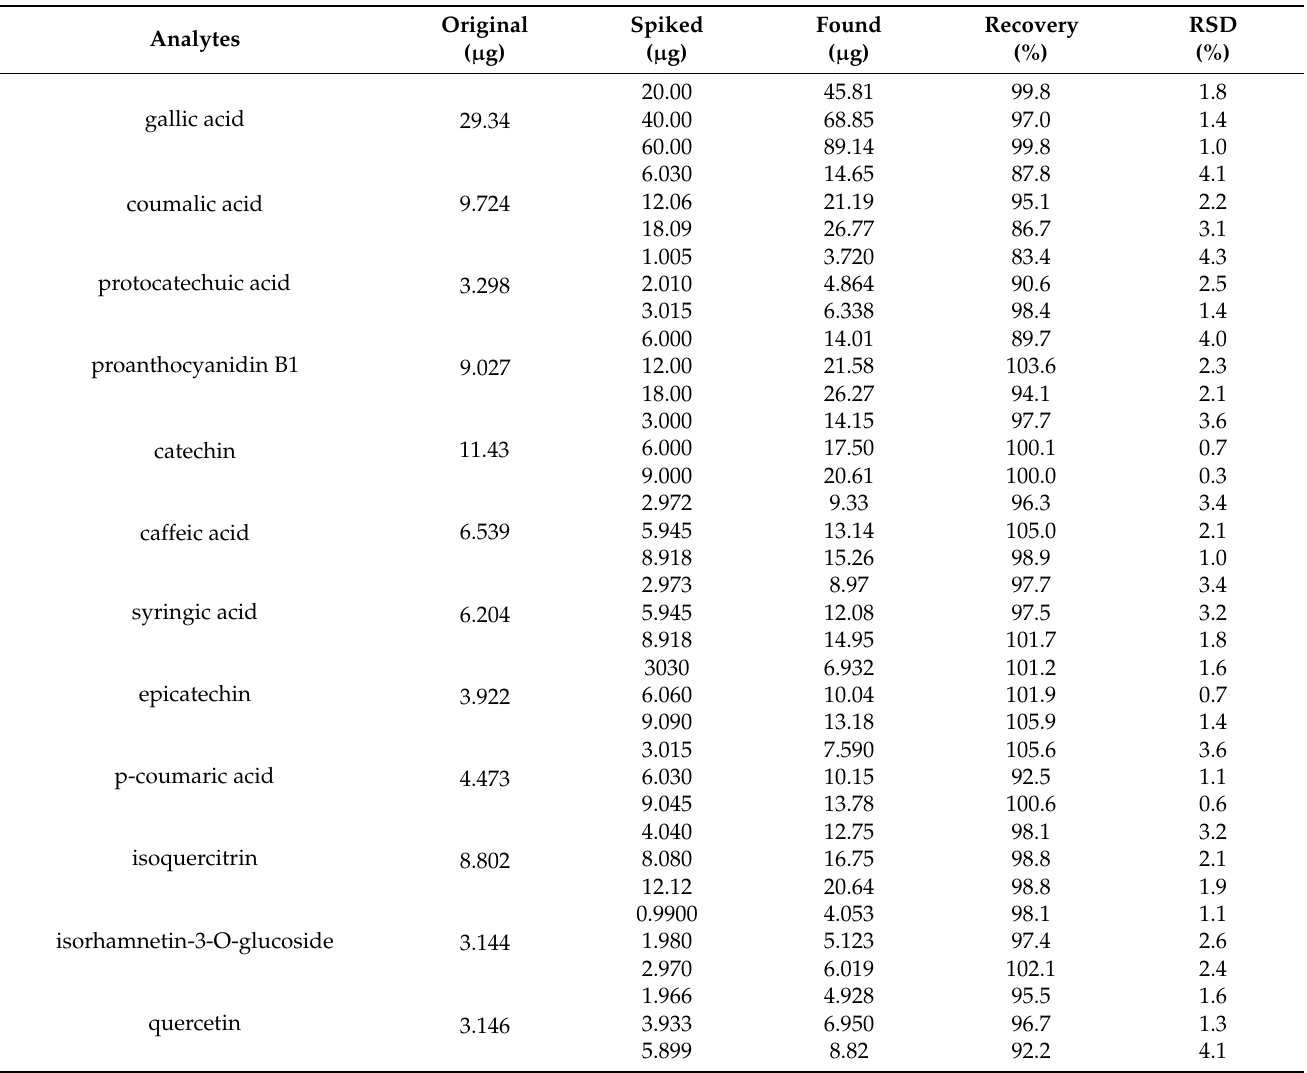
Table 5. The recovery of 12 compounds from red wine ( n =